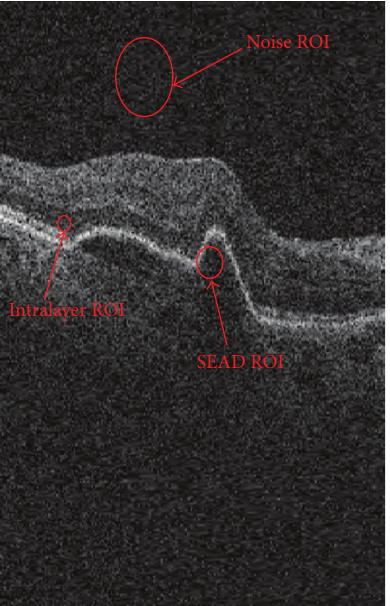
Figure 10: One slice from a sample OCT image and proposed ROIs for computation of MSNR and CNR reported in Table